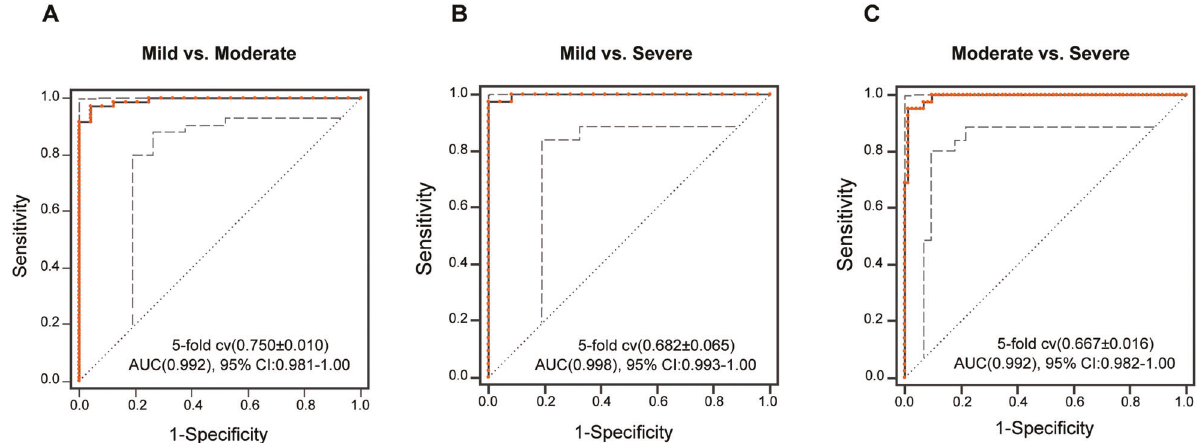
Fig. 5 Diagnosing MDD subgroups from gut microbiome features. A – C Based on the importance value of random forest analysis (>2%) between MDD subgroups and HCs, 37 species was identi fi ed (see Table S2 – 4 for importance value). This microbial panel enabled the differentiation between any 2 subgroups with high diagnostic accuracy (AUC, 0.992 –